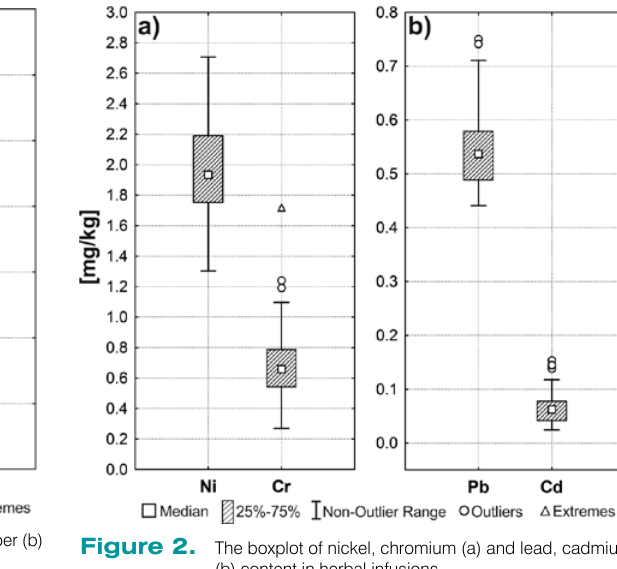
Figure 1. The boxplot of manganese, iron (a) and zinc, copper (b) content in herbal infusions.